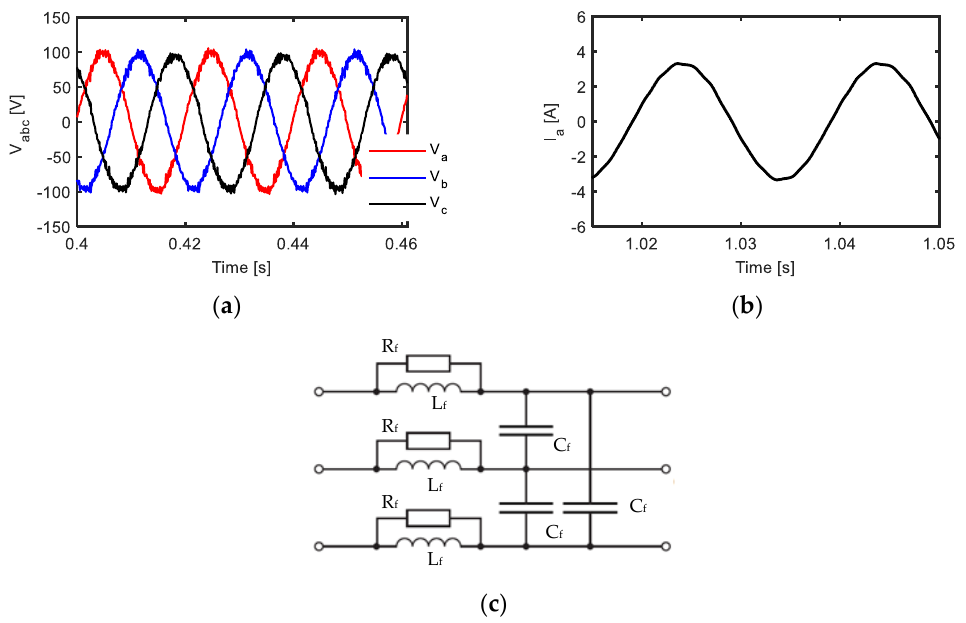
Figure 15. Measured ( a ) input phase voltage, ( b ) input phase current (filtered), and ( c ) input filter connected between supply and IMC.